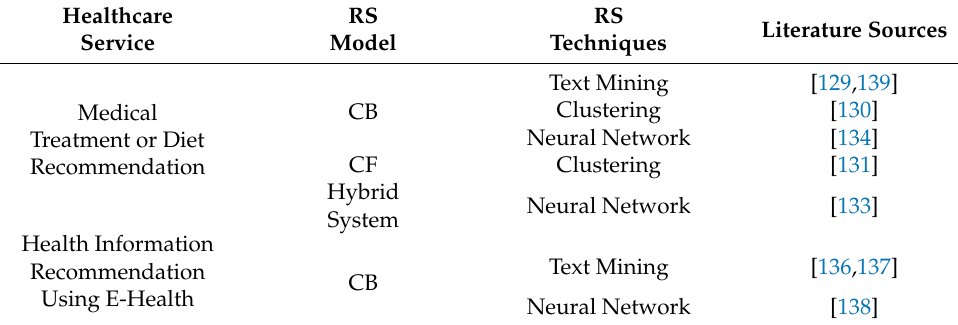
Table 9. Healthcare service field recommendation system